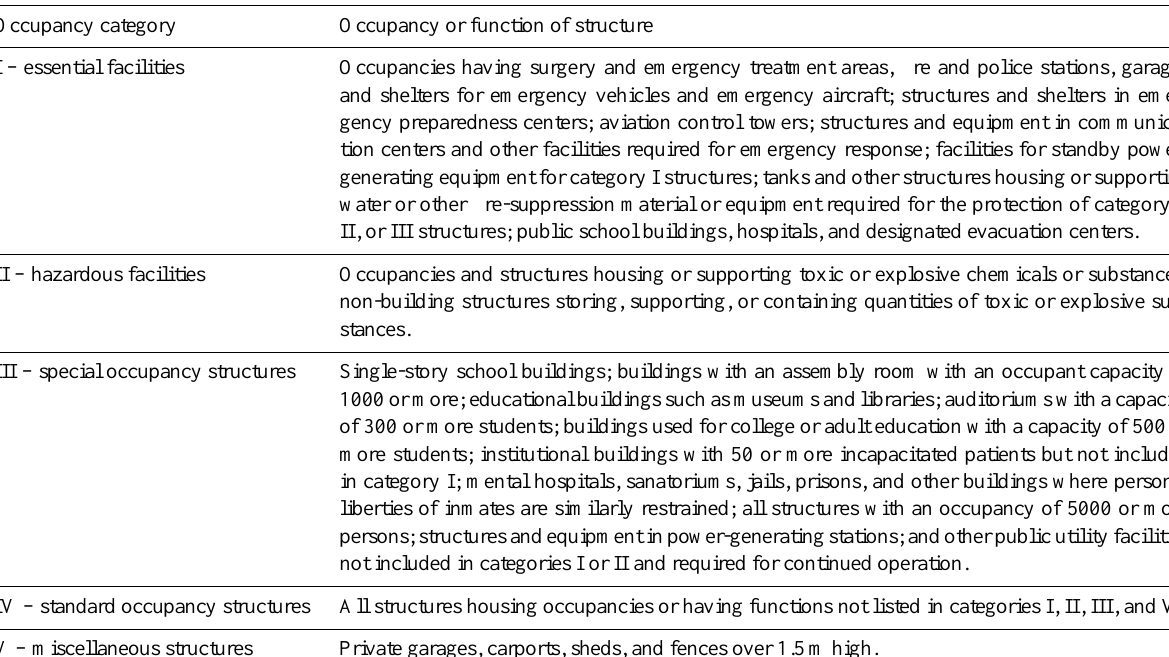
Table 2. Classification of structures and nature of occupancy (ASEP, 2010).